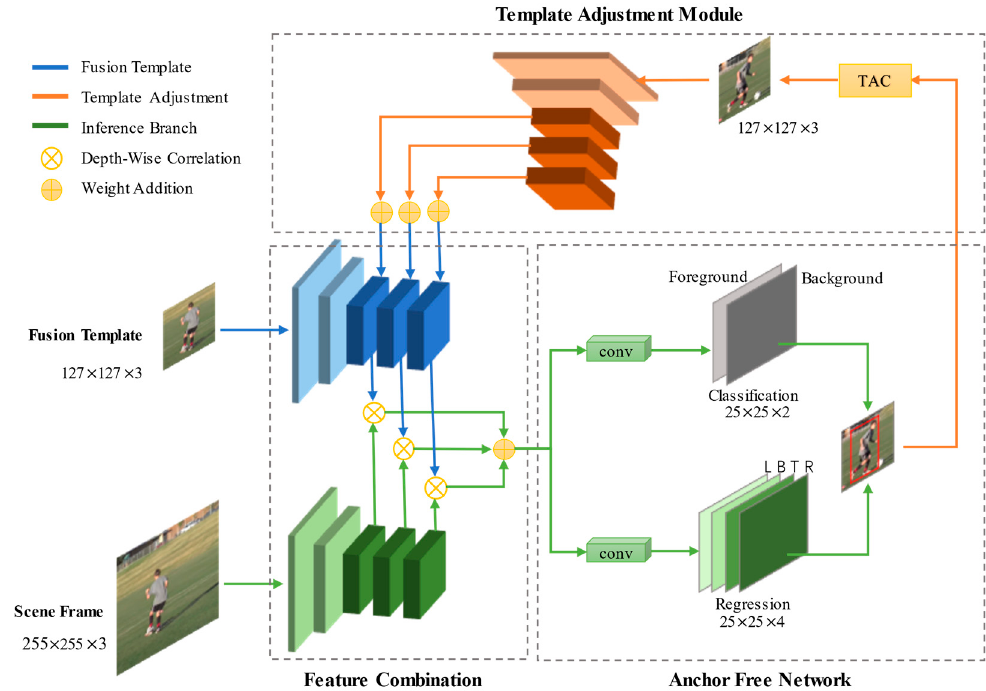
Figure 2. The overview of our proposed TA-Siam framework. TAC means Template Adjustment Controller. The template adjustment module has the characteristics of plug-and-play.